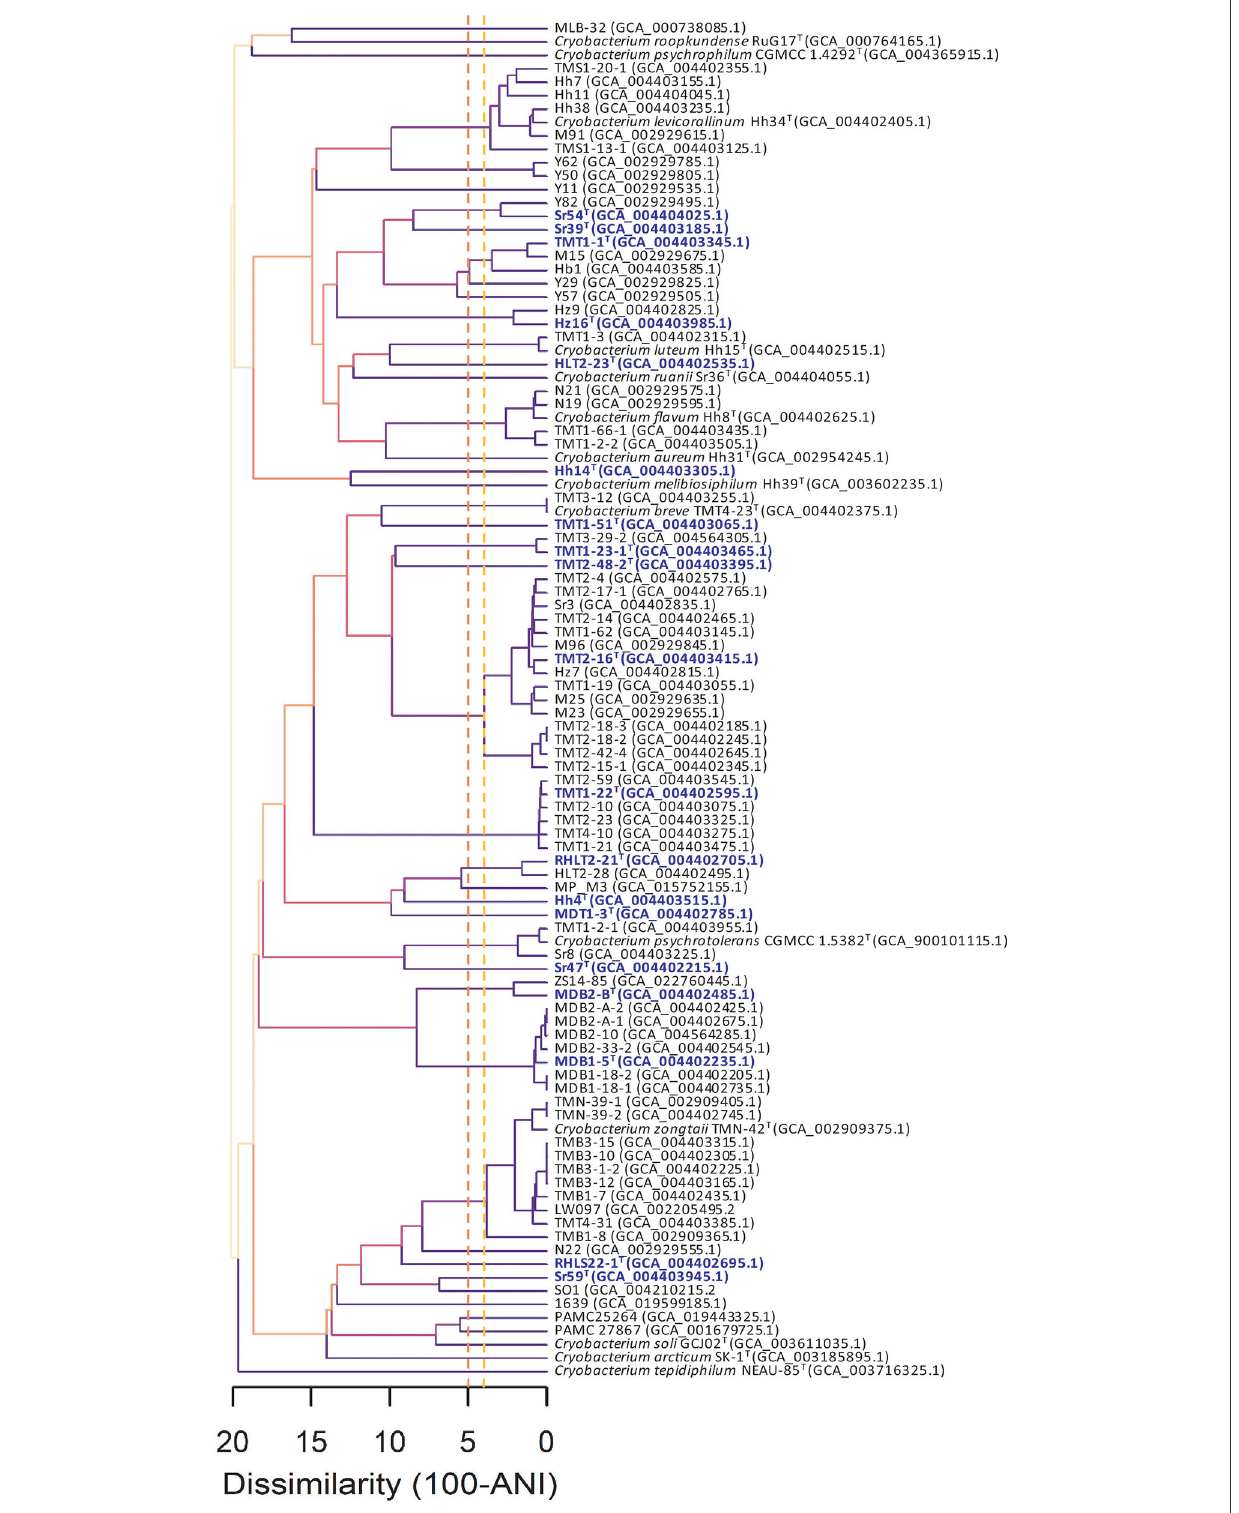
FIGURE1 Cluster analysis based on pairwise ANI values of 101 Cryobacterium strains. Accession numbers of the genomic sequences are given in parentheses. Nineteen strains representing the novel species described in this study are in purple